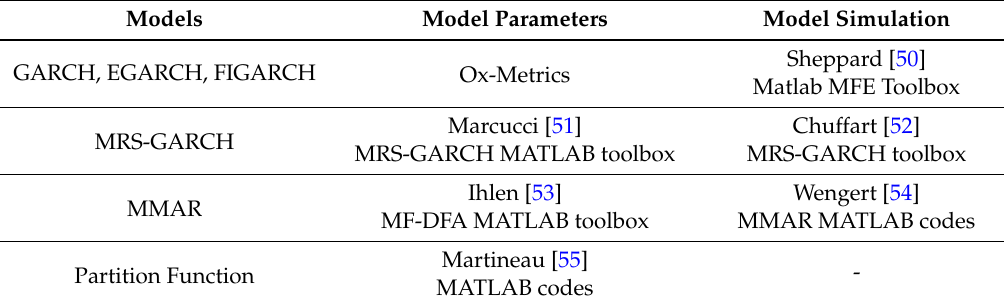
Table 1. Used codes and software.